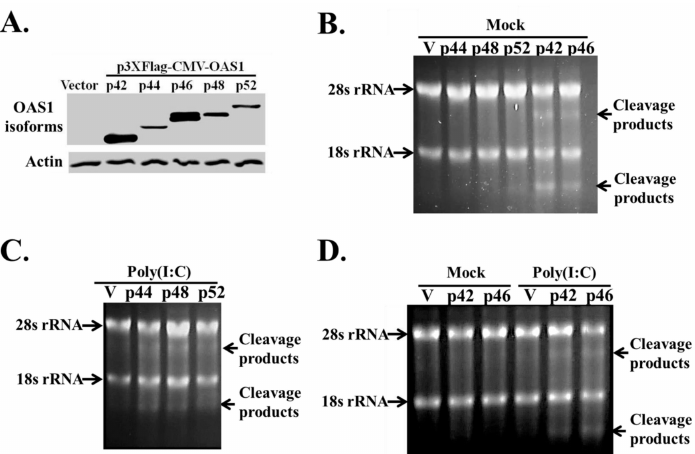
Figure 3. Analysis of RNase L cleavage in cells overexpressing individual hOAS1 isoforms in response to poly(I:C). HEK293 cells were transfected with 1 µ g of empty vector DNA, or of one of the hOAS1 isoforms cloned into the p3xFlag-CMV plasmid for 24 h. ( A ) Western blot analysis of the expression level of each OAS1 isoform, using anti-Flag and anti- β actin antibodies. HEK293 cells overexpressing each OAS1 isoform (1 µ g of plasmid DNA) for 24 h were either mock transfected ( B ), or transfected with poly(I:C) for 6 h ( C ). Total intracellular RNA was extracted and separated on a denaturing agarose gel and stained with ethidium bromide. ( D ) HEK293 cells were transfected with 0.5 µ g p42 or p46 plasmid DNA for 9 h, followed by either mock transfection, or transfection with poly(I:C) for 6 h. Total intracellular RNA was extracted and separated on a denaturing agarose gel and stained with ethidium bromide. The 18S / 28S rRNA and their cleavage products are indicated by arrows. V: empty vector control.